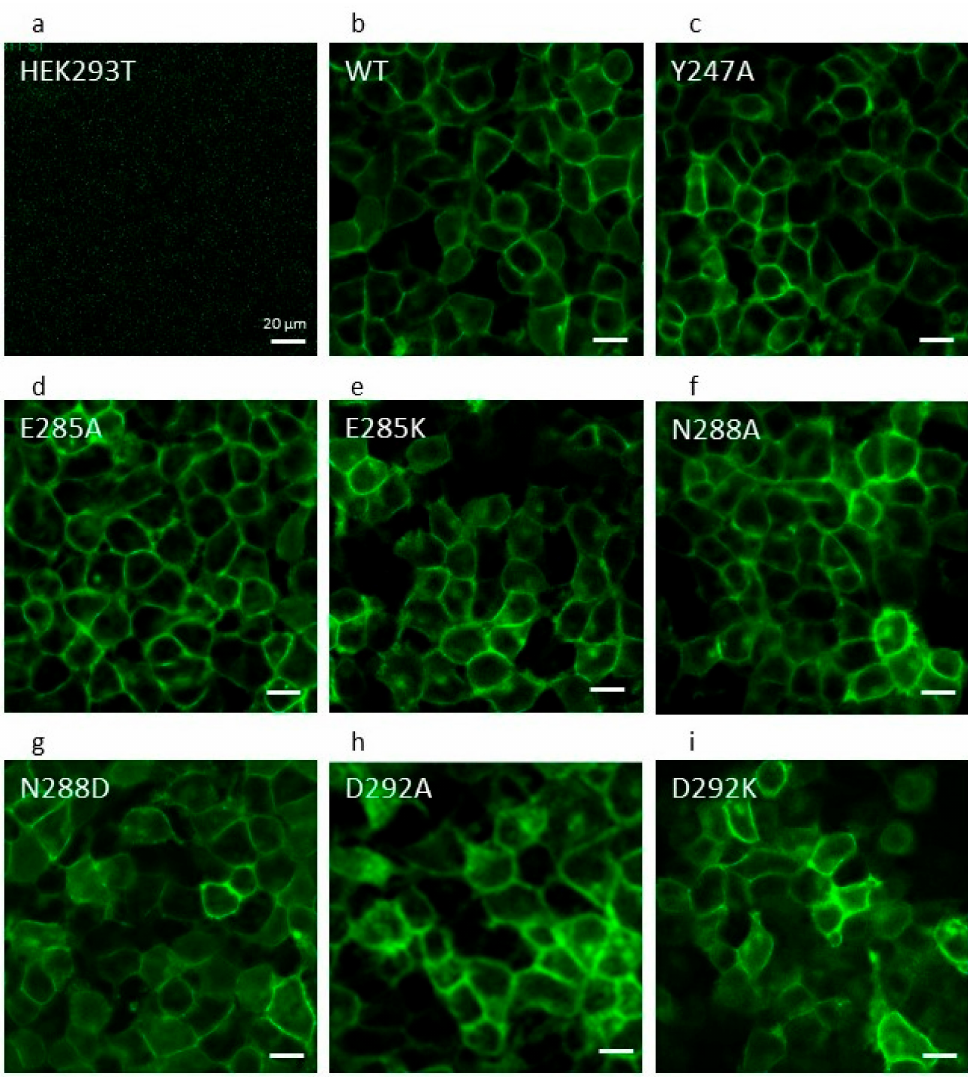
Figure 2. Cell surface localisation of NBD interface residues. Confocal microscopy was performed to visualize cell surface localization of ABCG2 isoforms in stable cell lines ( a – i ). The majority of the mutant isoforms showed evidence of cell membrane localization with varying levels of protein expression comparable to the wild type. Live cells were imaged using an ImageXpress (IX) Ultra confocal plate reader (plan-apochromat 40 × objective, with excitation wavelength of 488 nm and emission bandpass filter of 520 / 50 nm). Scale bars represent 20 µ